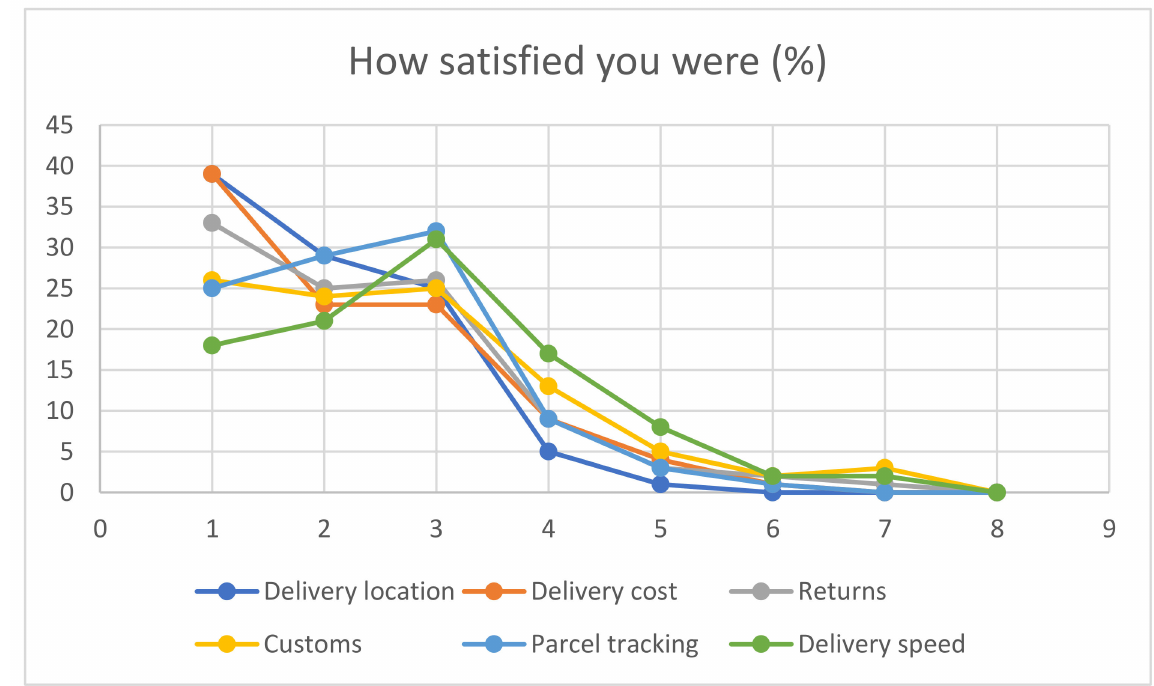
Figure 3. Satisfaction feedback for value adding